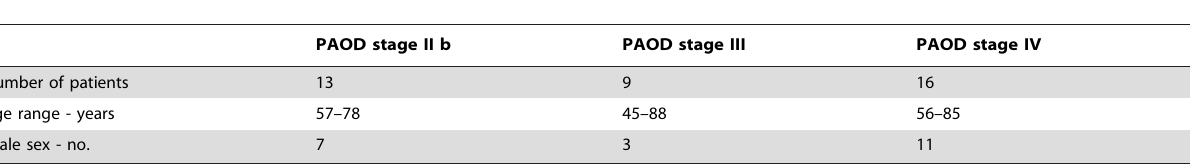
Table 1. Clinical and demographic characteristics of the study population.